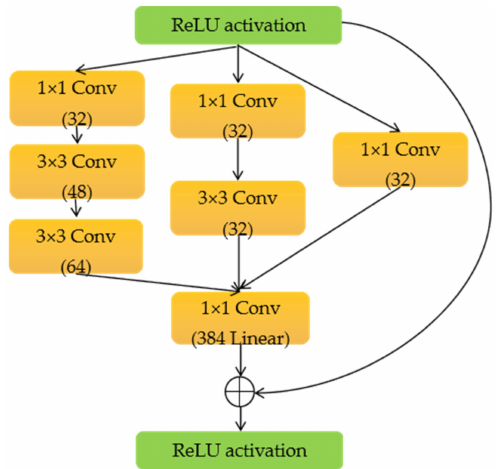
Figure 8. The architecture of Inception-Resnet-A.